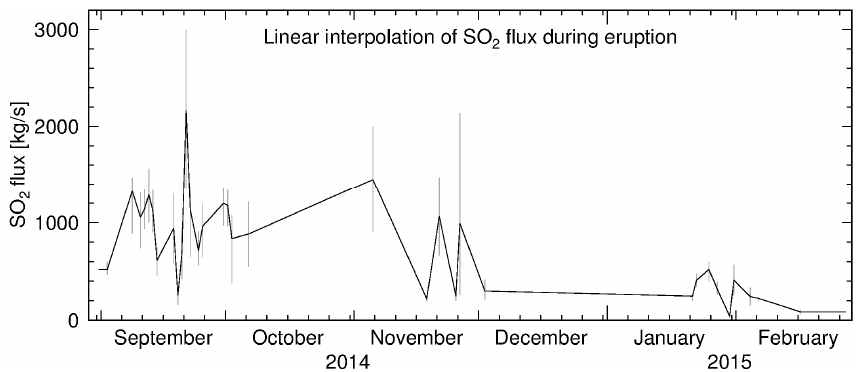
Figure 6. Time series of the daily average SO 2 flux measured by DOAS connected with a solid black line showing the linear interpolation of the data between measurement dates. The gray vertical bars show the uncertainty for each day.